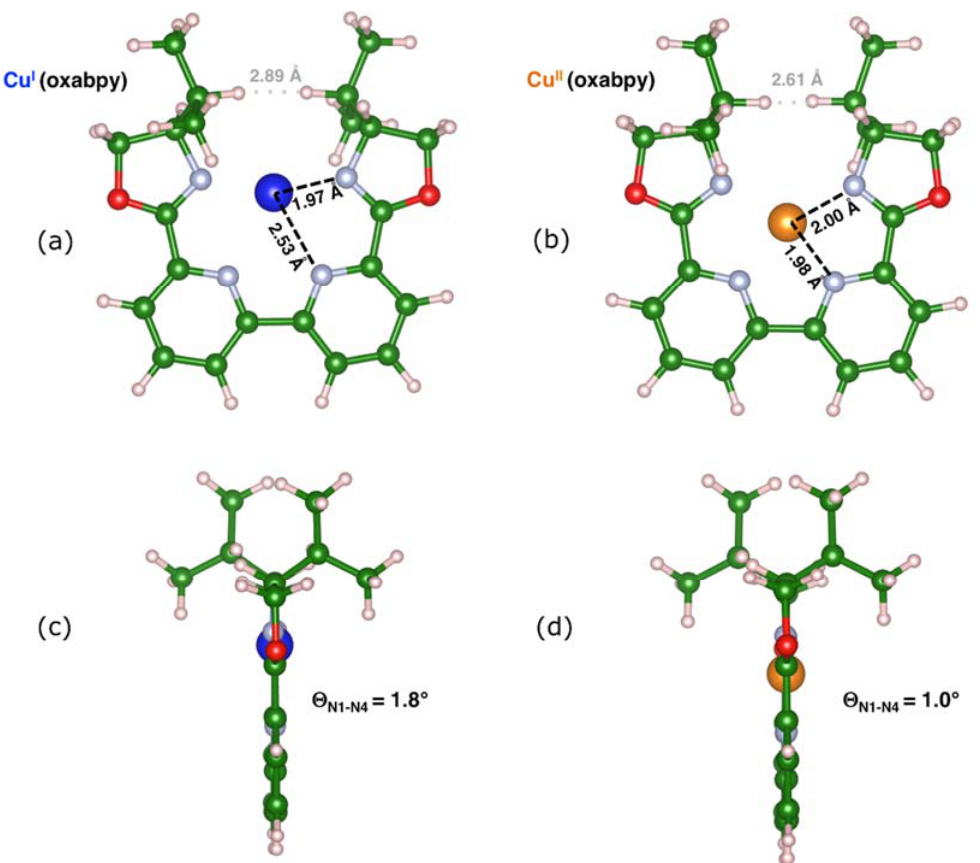
Figure 4. Cu I (oxabpy) ( a , c ) and Cu II (oxabpy) ( b , d ) minimum ‐ energy structures calculated at the DFT/B3LYP ‐ D3BJ level of theory in acetonitrile (PCM). ( a , b ): top view. Non ‐ equivalent Cu–N distances (black dashed lines) and distances between germinal H of terminal isopropyl groups (grey dotted lines) are indicated. ( c , d ): lateral view. Dihedral angles of each N1–N2–N3–N4 plane ( Θ N1–N4 ) are indicated.